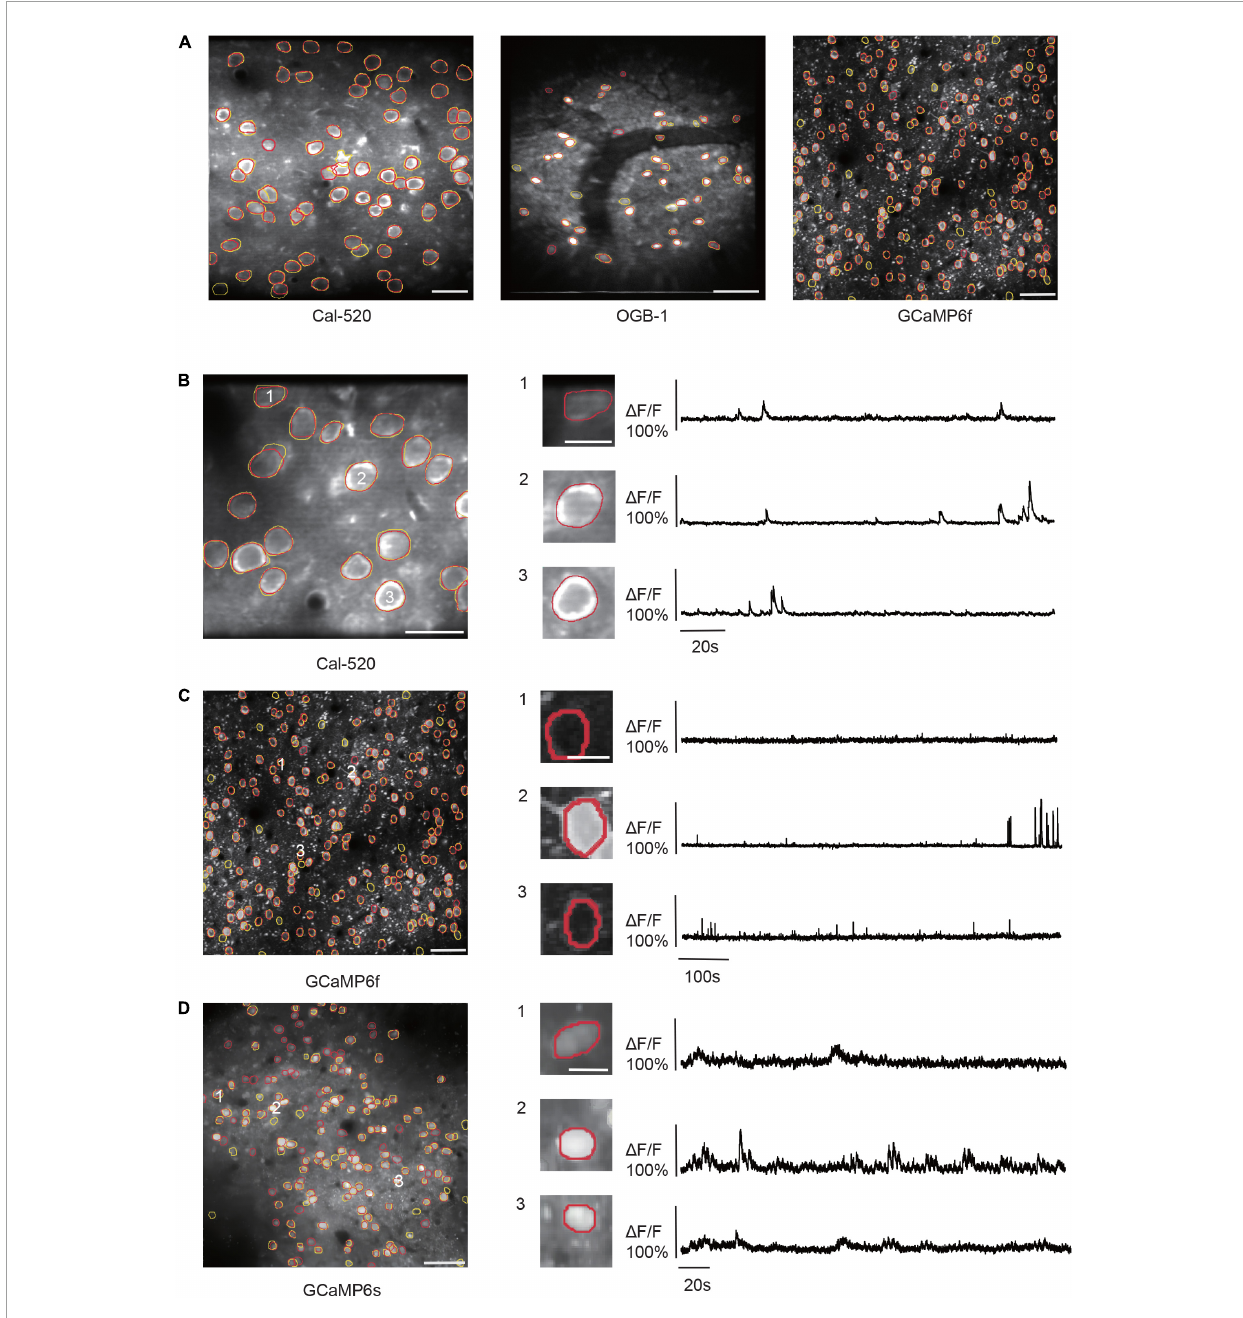
FIGURE6 Results of NeuroSeg-II performing generalized neuron segmentation. (A) Examples showing the neuron segmentation results for Cal-520 (precision = 0.9677, recall = 0.9375, and F1-score = 0.9524; the dataset from our lab), OGB-1 (precision = 0.875, recall = 0.8333, and F1-score = 0.8536; the dataset from our lab), and GCaMP6f (precision = 0.9779, recall = 0.8634, and F1-score = 0.9207; the dataset from ABO dataset, experiment ID: 536323956). The yellow outlines indicate the GT neurons, and the red outlines indicate the neurons detected by NeuroSeg-II. Cal-520: scale bar, 20 µ m. OGB-1: scale bar, 50 µ m; GCaMP6f: scale bar, 50 µ m. (B–D) Examples showing the neuron segmentation of active and inactive neurons in the imaging data for (B) Cal-520 (precision = 1.0, recall = 1.0, and F1-score = 1.0; data from our lab), (C) GCaMP6f (precision = 0.9779, recall = 0.8634, and F1-score = 0.9171; data from ABO dataset, experiment ID: 536323956), and (D) GCaMP6s (precision = 0.6490, recall = 0.7967, and F1-score = 0.7153; data from Neurofinder dataset, experiment ID: 01.01test). The left side is the segmentation result, and the right side is the activities of three representative neurons (scale bar, 10 µ m). The yellow outlines indicate the GT neurons, and the red outlines indicate the neurons segmented by NeuroSeg-II. Cal-520: scale bar, 20 µ m. GCaMP6f: scale bar, 50 µ m. GCaMP6s: scale bar, 50 µ